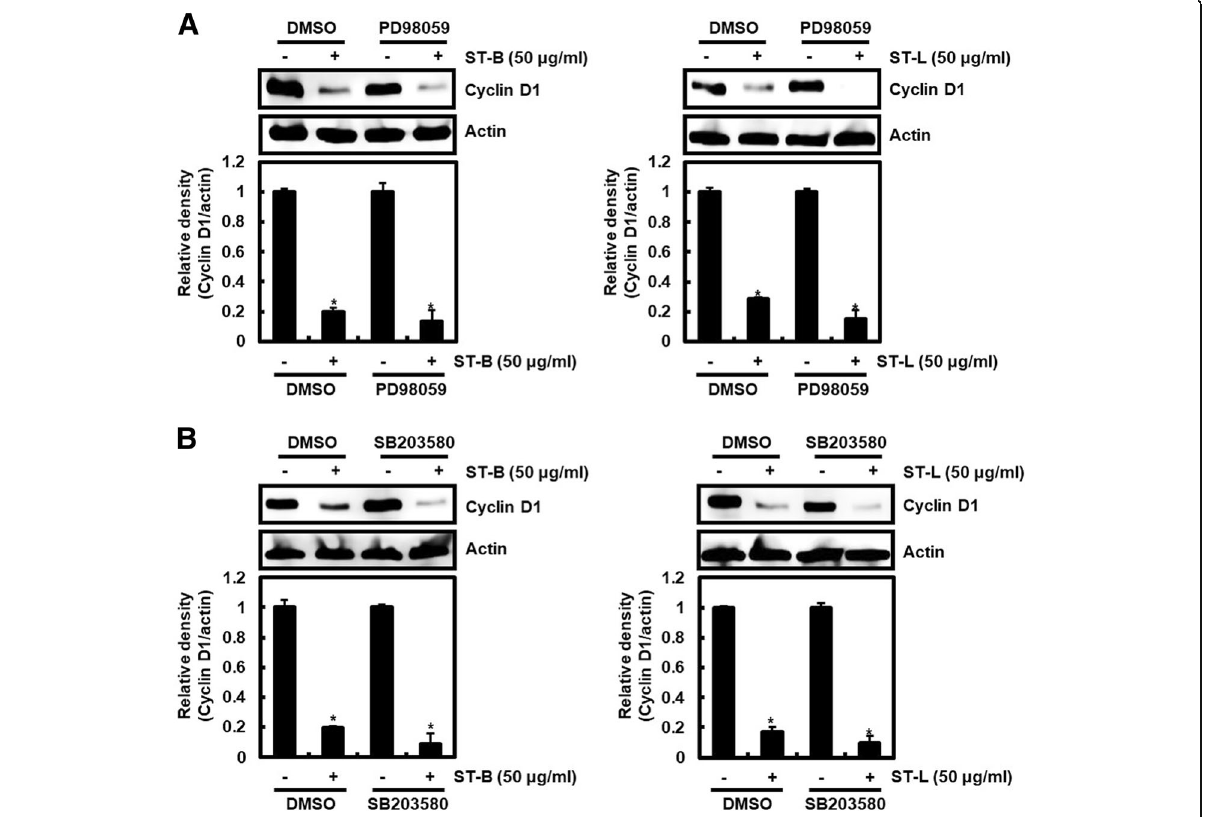
Fig. 3 Cyclin D1 degradation by STL and STB is independent on ERK1/2 and p38. a and b SW480 cells were treated with PD98059 (20 μ M) or SB203580 (20 μ M) for 2 h, and then co-treated with STL and STB for the additional 6 h. Actin was used as loading control. * P < 0.05 compared to the cells without STL and